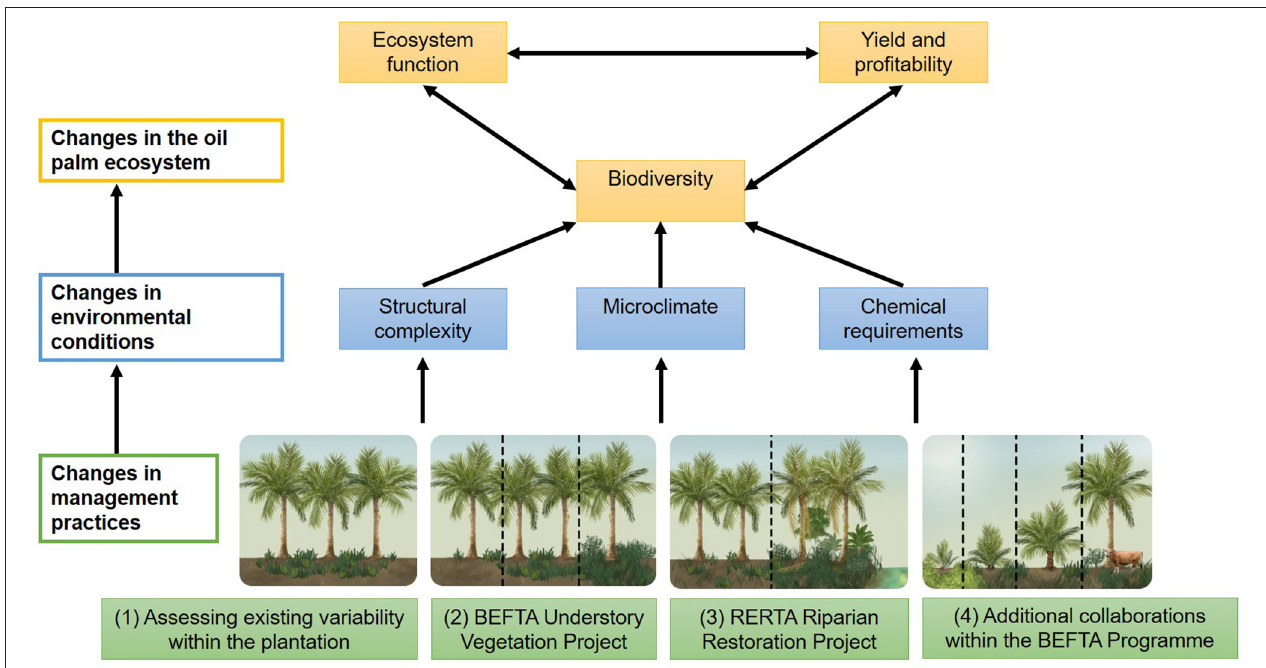
FIGURE 2 | Schematic to show the four key research components of the BEFTA Programme: (1) Assessing existing variability within the oil palm plantation under business-as-usual practices; (2) the BEFTA Understory Vegetation Project experimental manipulation; (3) the RERTA Project experimental manipulation of riparian restoration; (4) and a suite of additional collaborative projects that test a range of other management strategies within the plantation system. We anticipate that use of different management practices will cause changes in environmental conditions (including structural complexity of the habitat, microclimate, and the requirement for chemical inputs such as fertilisers and pesticides). This, in turn, will have effects on how the oil palm ecosystem operates, with changes in biodiversity, ecosystem functions, yield and profitability, and feedbacks between all three. By gaining a better understanding of how management decisions affect the oil palm ecosystem, the BEFTA Programme aims to improve the sustainability of palm oil production. In this paper we present initial results on the effects of management on structural complexity and microclimate. Other published studies from the BEFTA Programme present results on the effects of management on a range of environmental conditions, biodiversity, and functions ( Foster et al., 2014; Slade et al., 2014; Kurz et al., 2016; Tao et al., 2016, 2017, 2018; Ashton-Butt et al., 2018, 2019; Spear et al., 2018; Eycott et al., 2019; Hood et al., 2019; Luke et al., 2019a; Woodham et al., 2019 ). Additional studies, which are still in preparation, will further extend our understanding of these linkages, and also consider impacts on yield, profitability, and recommendations for the